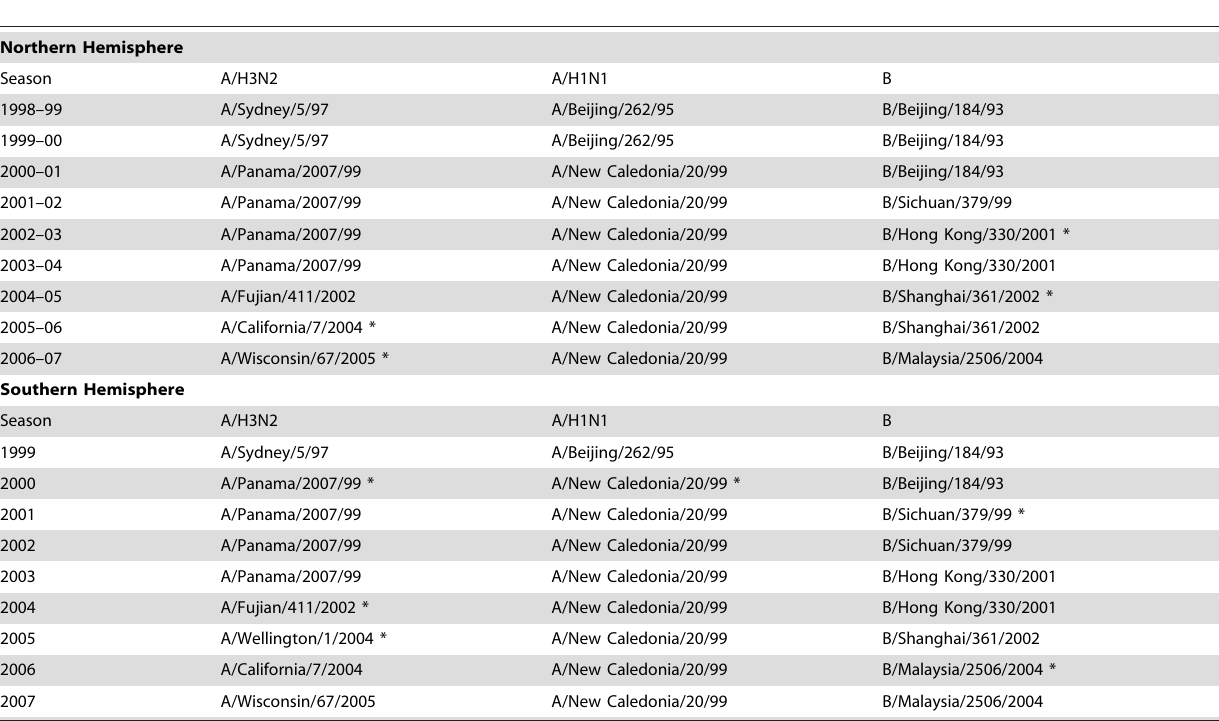
Table 1. WHO influenza vaccine recommendations for the Southern and Northern Hemisphere, 1999–2007: antigenic characterization of the strains recommended for inclusion in the trivalent vaccine, by hemisphere, influenza season and subtype